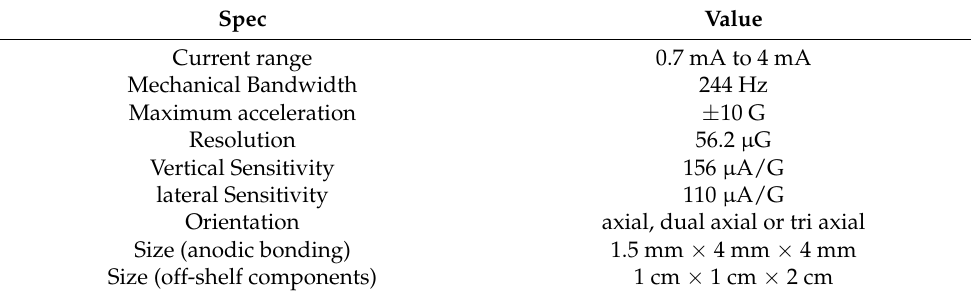
Table 1. Specs of the proposed optical accelerometer based on design